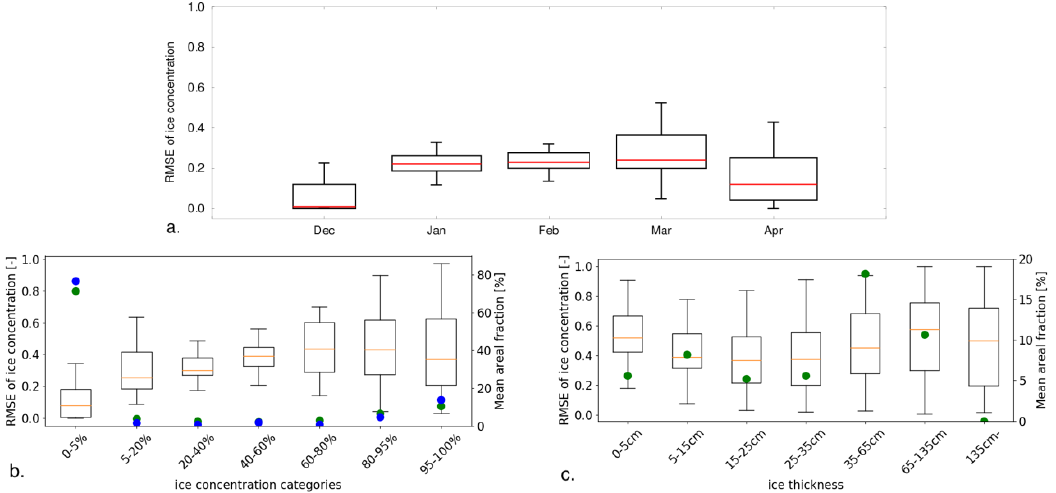
Figure 8. Ranges of spatial concentration RMSE as functions of month ( a ), ice concentration ( b ) and ice thickness ( c ) for Lake Michigan from the LMHOFS 2015–2017 simulation results. See the caption of Figure 5 for the explanation of the box, whiskers, and solid circles. For ( c ), open water cells are excluded.